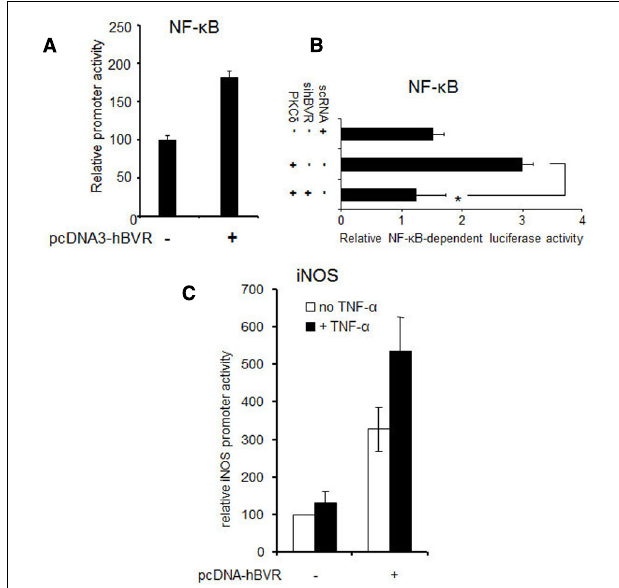
FIGURE 5 | BVR enhances ERK1/2-dependent transcriptional activation. (A) NF- k B-dependent promoter activity is stimulated by